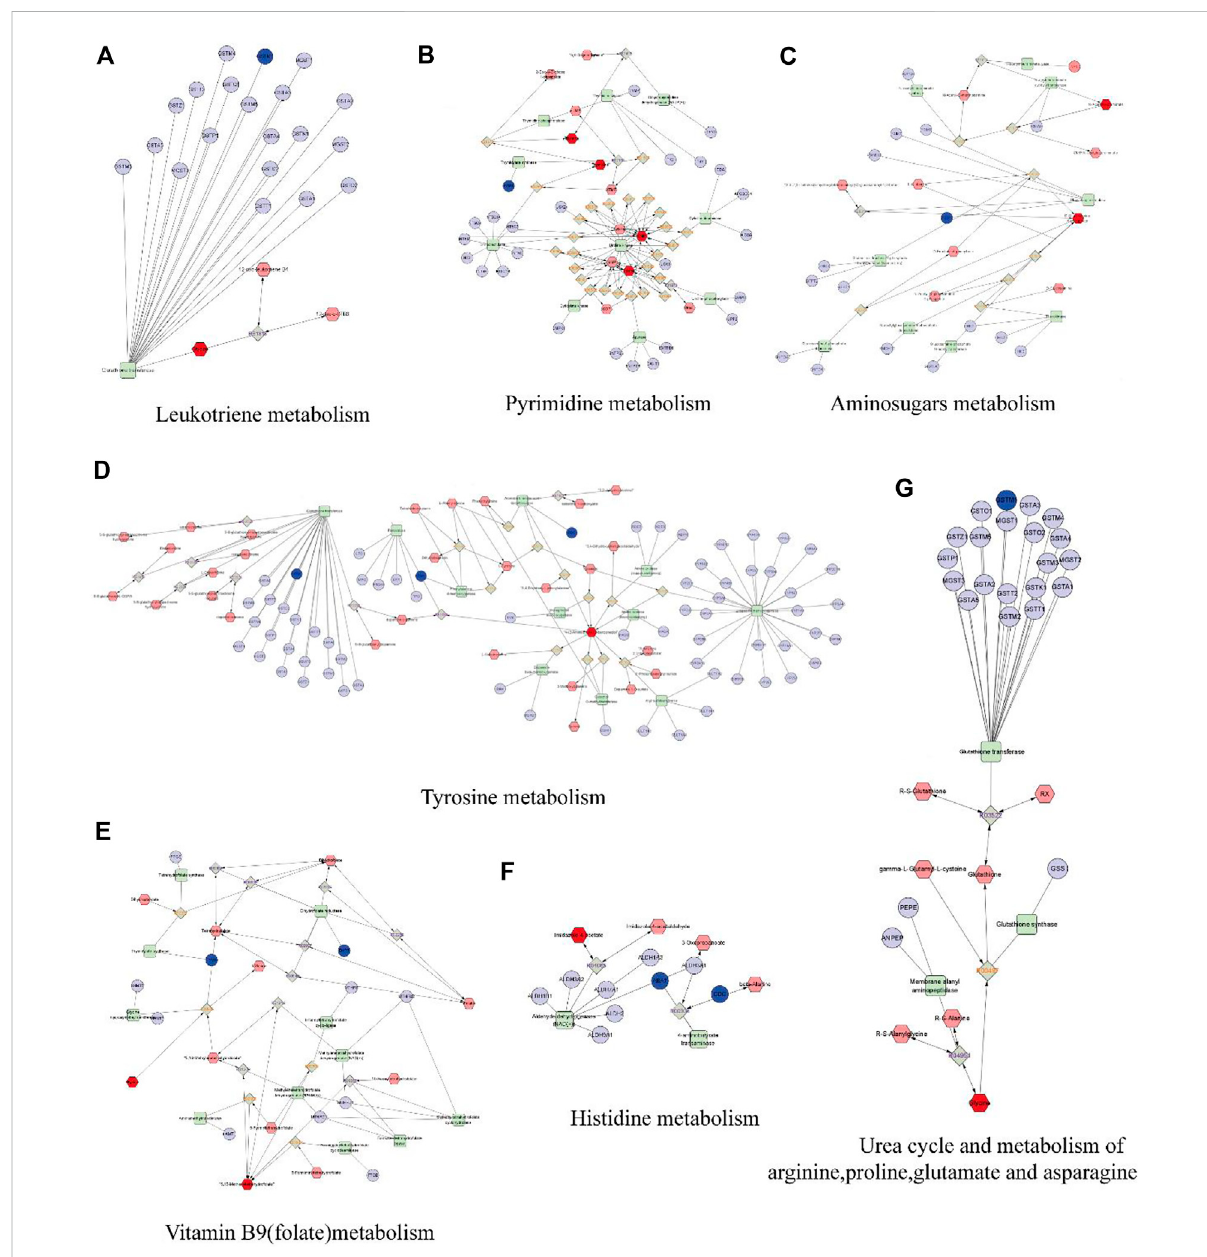
FIGURE 10 The compound-reaction-enzyme-gene networks of the crucial targets and metabolites. The red hexagons represent the active compounds. Thegreydiamondsrepresentthereaction.Thegreenroundrectanglerepresentenzyme.Thelightpurplecirclespresentgeneralgenes,andtheblue circles represent key genes. (A) Leukotriene metabolism. (B) Pyrimidine metabolism. (C) Amino sugars metabolism. (D) Tyrosine metabolism. (E) Vitamin B9 (folate) metabolism. (F) Histidine metabolism. (G) Urea cycle and metabolism of arginine, proline, glutamate and